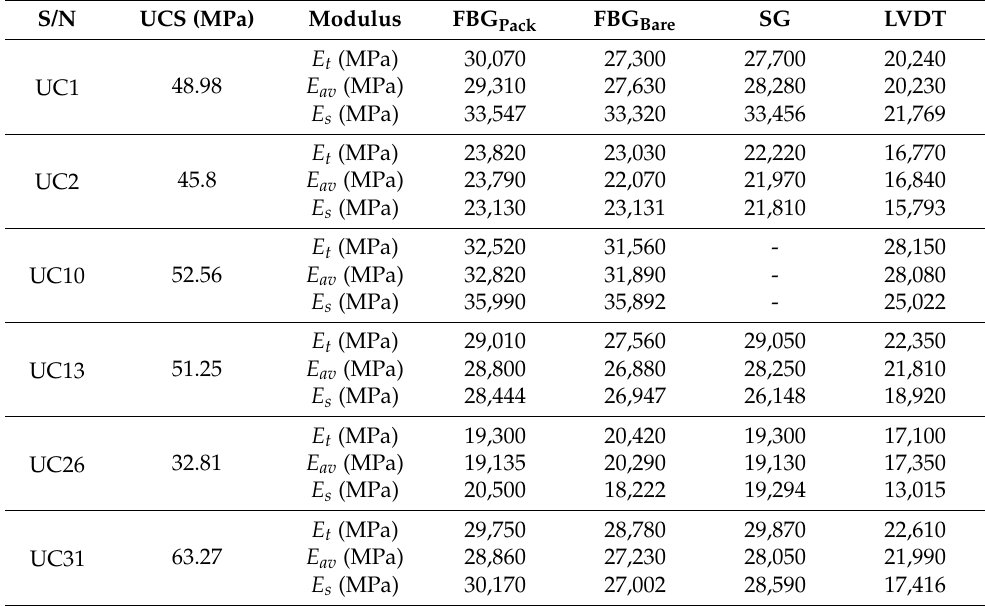
Table 2. UCS and Young’s modulus obtained from all the sensors on each specimen.